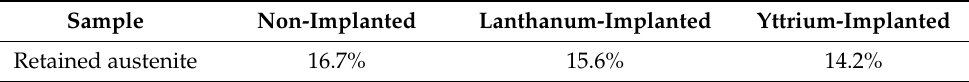
Figure 8. XRD spectra of the carburized layers of the three samples—( a ) XRD spectra; ( b ) di ff raction angle of the (110) peak; ( c ) di ff raction angle of the (200) peak; and ( d ) di ff raction angle of the (211) peak. Table 2. Retained austenite content in the carburized surface layer of the three samples by